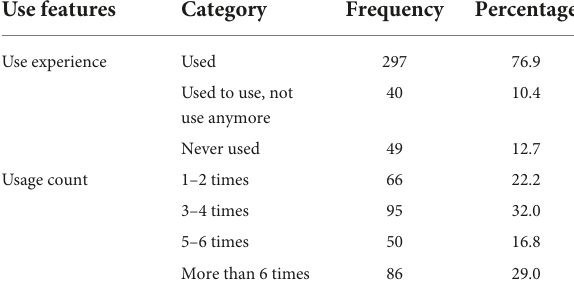
TABLE 4 Usage of